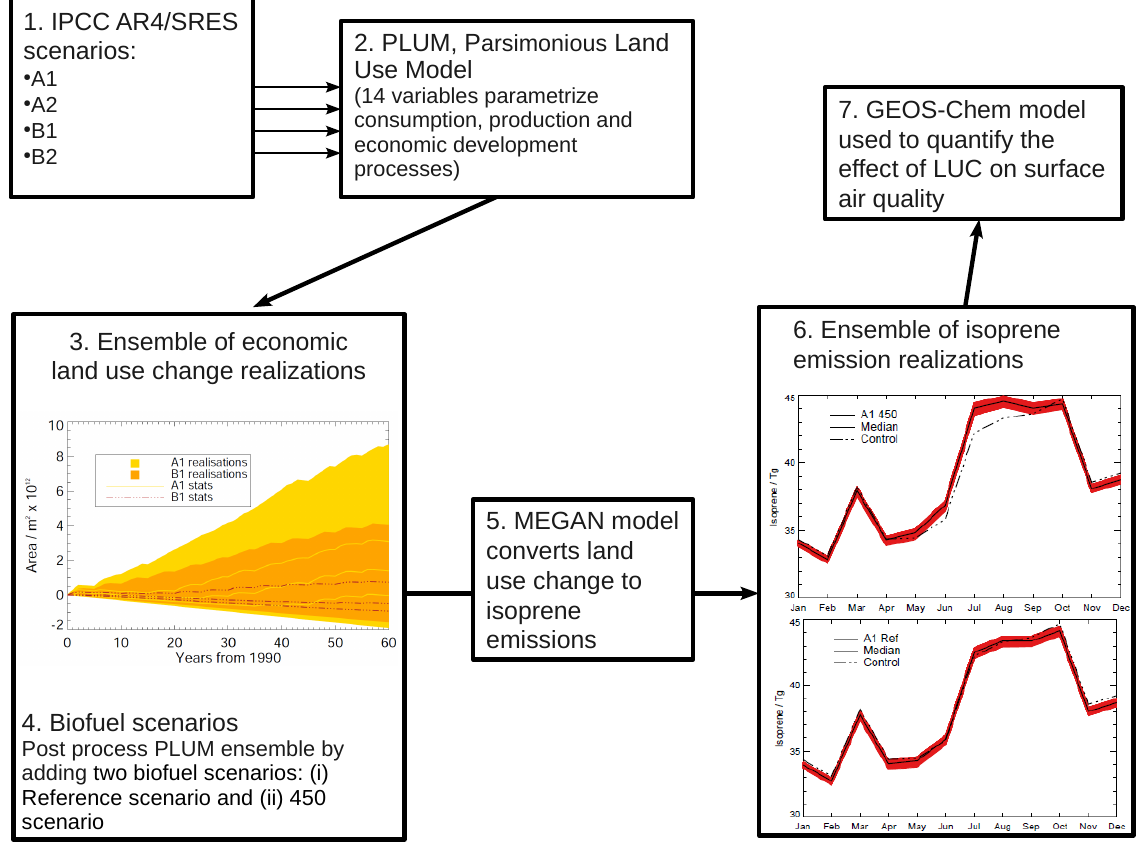
Fig. 1. Schematic illustrating the overall methodology used in our study to determine probabilistic estimates of changes in BVOC emissions and surface ozone from ensemble LUC estimates from a simplified system dynamics